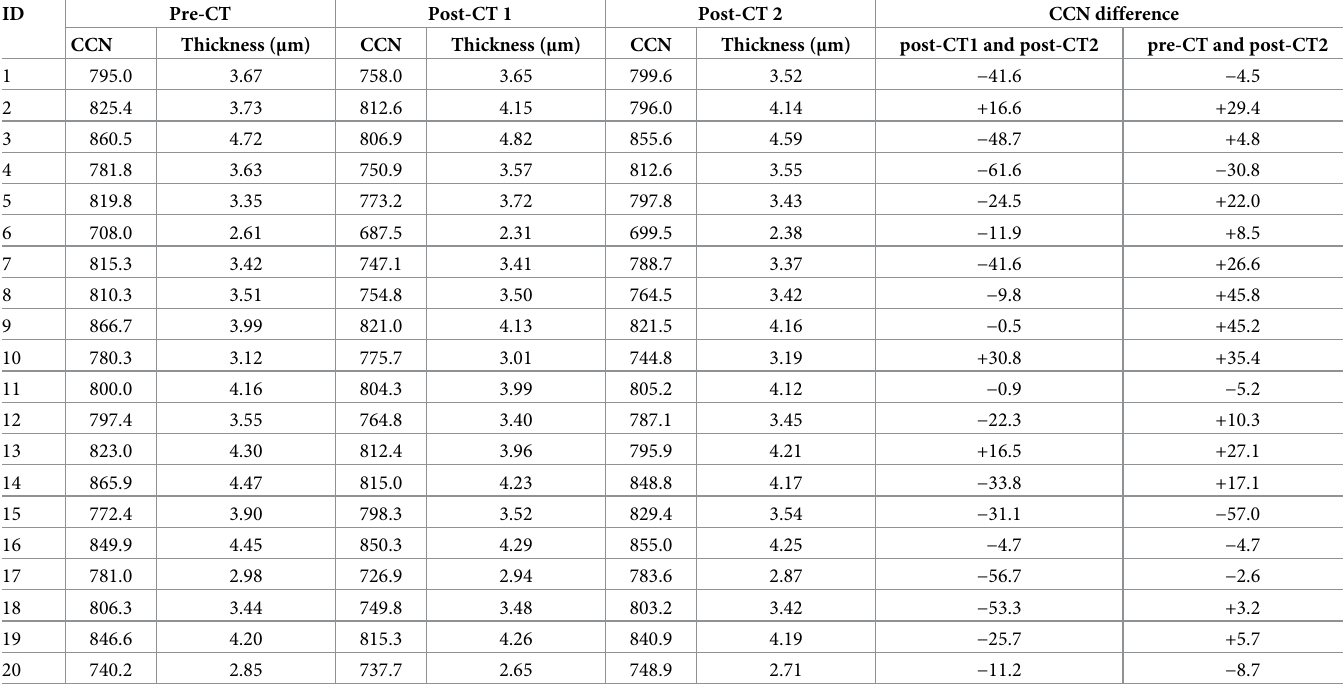
Table 1. Calcite computed tomography (CT) number (CCN) and shell thickness of the planktic foraminifer Globigerinoides ruber